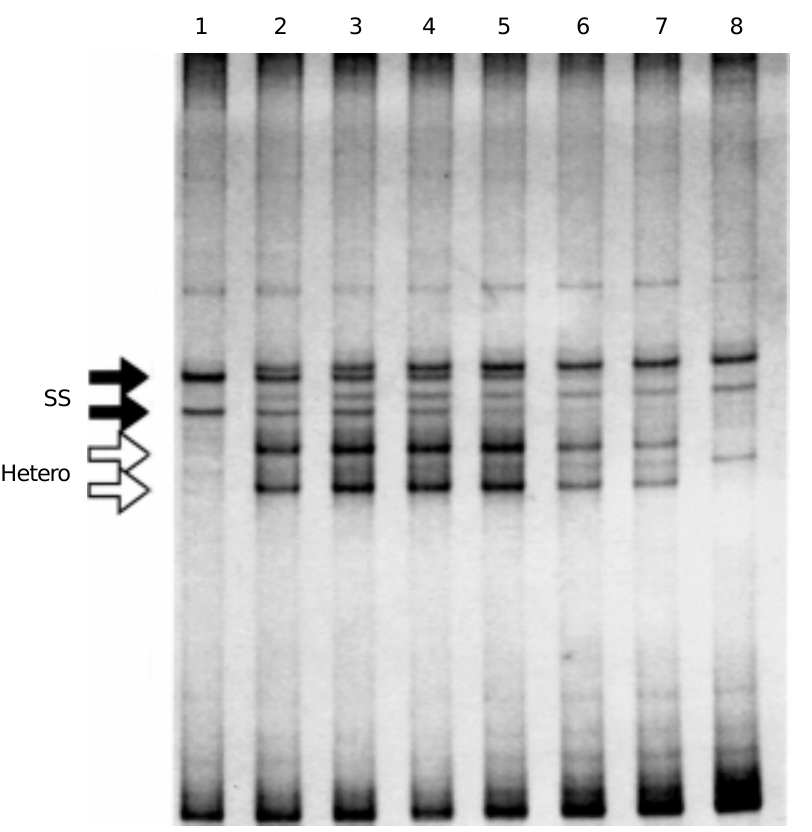
8 Figure 2 - SSCP-PCR analysis of